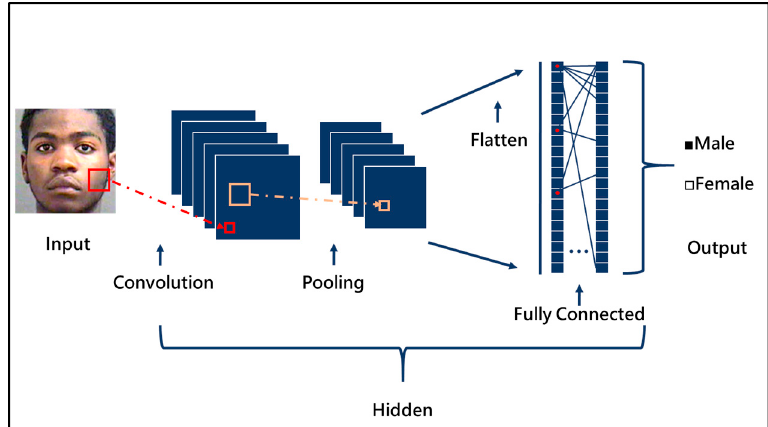
Figure 2. Structure of a basic convolutional neural network.